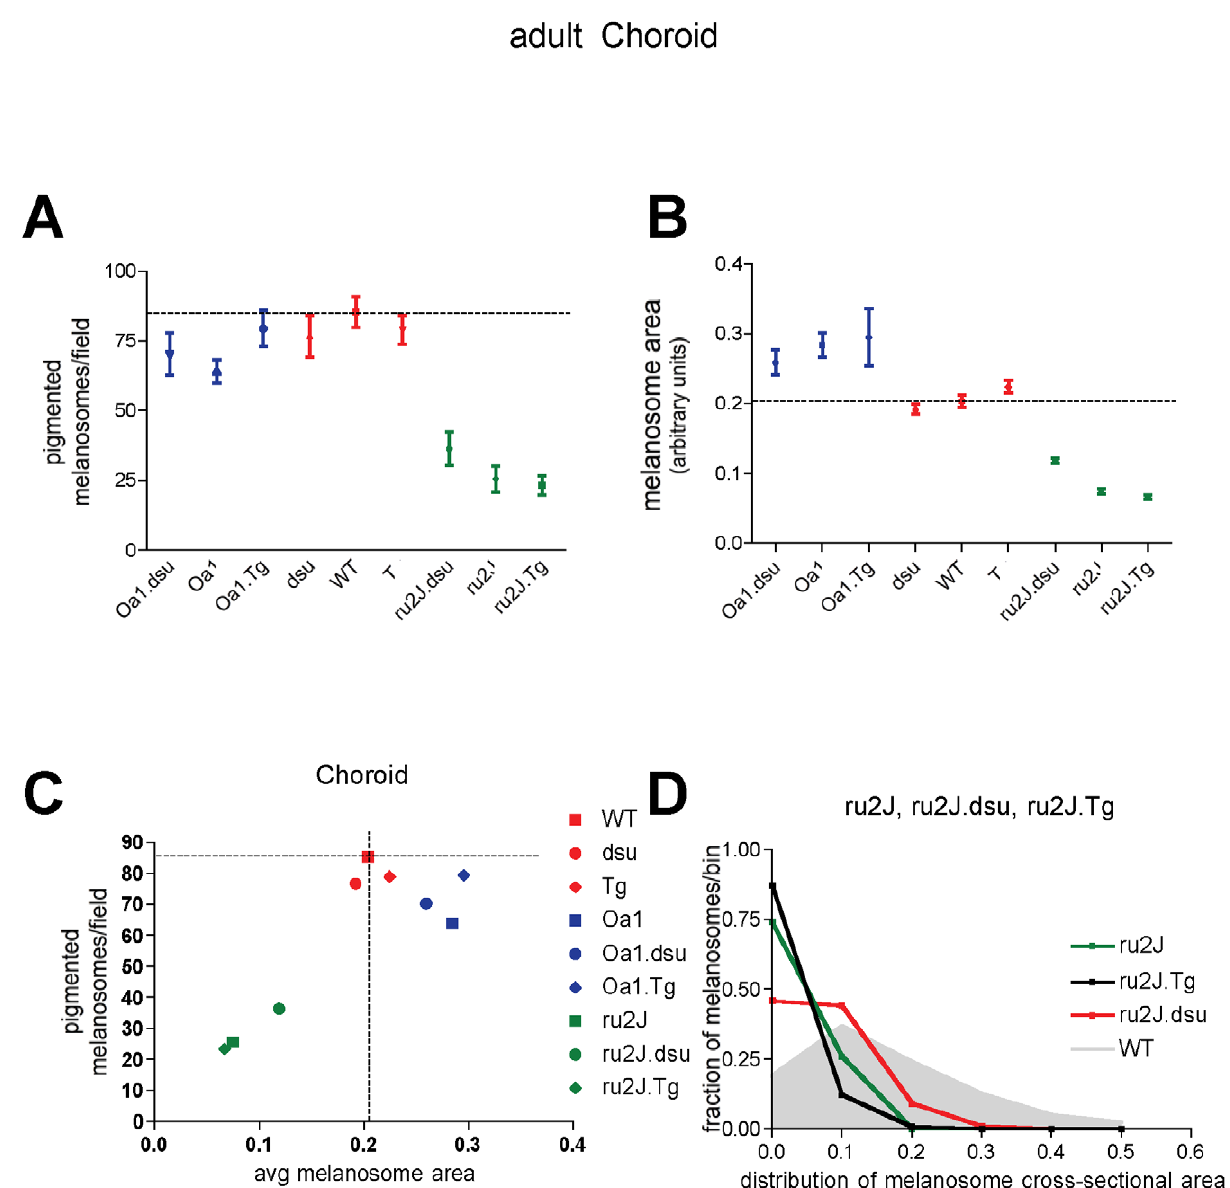
Figure 5. Melanoregulin levels influence melanosome characteristics in the choroid of Hps5 ru2J and Oa1 mutant mice. Quantitation and analysis of the data shown in Figure 4. Data points are mean values 6 SEM. A. Melanosome number and B. Melanosome area on an Oa1 null background do not show a statistically significant change as a function of melanoregulin dose; all p values are p . 0.05. In contrast, in Hps5 ru2J mice, both melanosome number and area increase, p , 0.05. Mreg dsu mice show a significant increase in melanosome area, p , 0.05, with melanoregulin over-expression ( Mreg Tg ) and a decrease from wildtype in melanoregulin loss of function mice ( Mreg dsu ), p , 0.05, with no significant change in number of melanosomes in either case, p . 0.05. C. The number of pigmented melanosomes per field is compared to the average melanosomal area in wildtype (C57Bl6/J) mice.